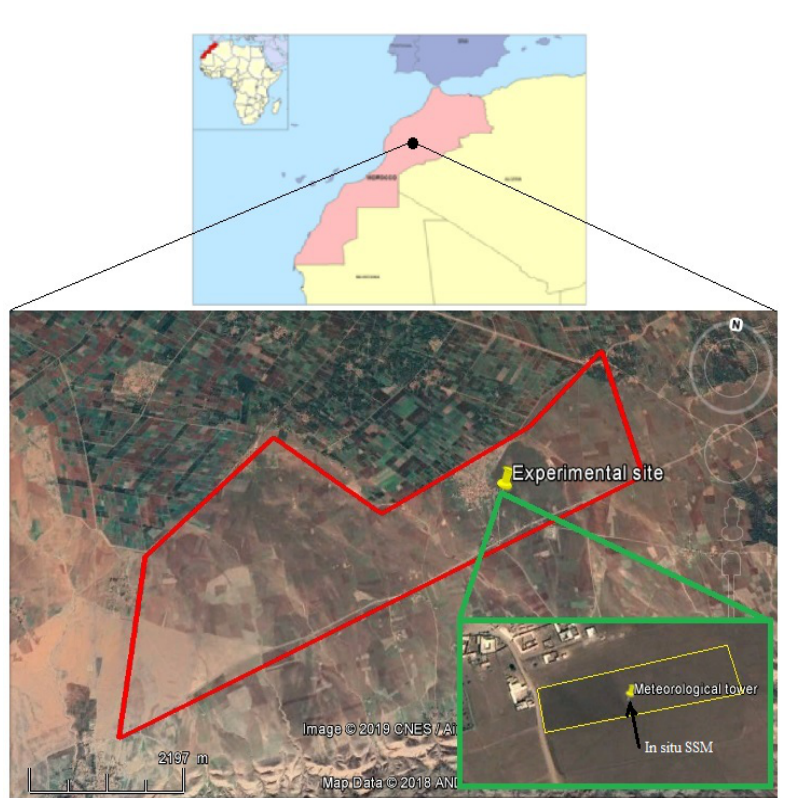
Figure 1. Location of Sidi Rahal site (east of Marrakech) in the Tensift basin, central Morocco. The experimental site (green contour), experimental field (yellow contour), positions of meteorological tower, in situ soil moisture measurements, and the areas of soil moisture (red contour) are